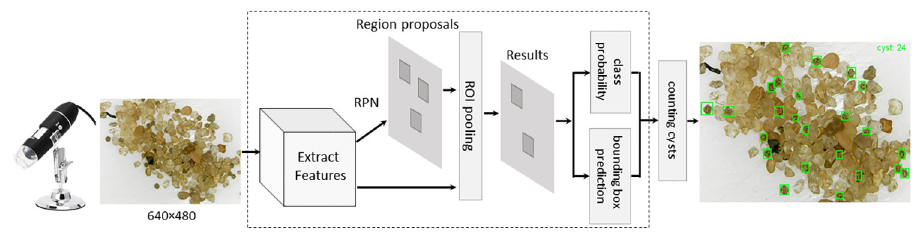
Fig 6. Overview of the automatized approach for Dendrocephalus Brasiliensis cysts detection and counting using Faster R-CNN architecture.